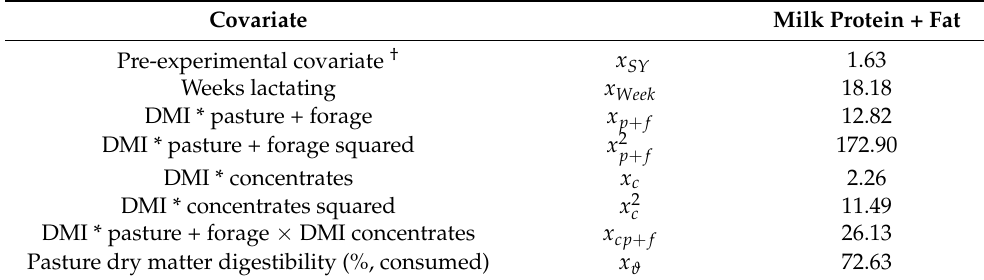
Table 6. Means of covariates from the final model for milk protein plus fat yield (kg/cow · day). Covariate Milk Protein + Fat Pre-experimental covariate † x SY 1.63 Weeks